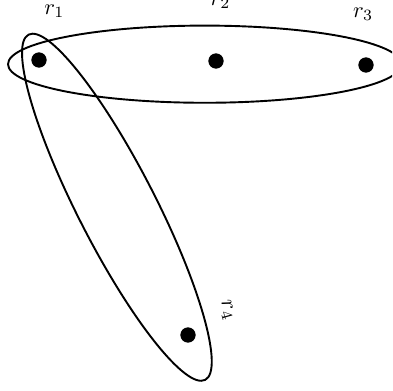
( α 1 e ι Θ 1 , β 1 e ι Φ 1 , γ 1 e ι Ψ 1 ) , Figure 3. H